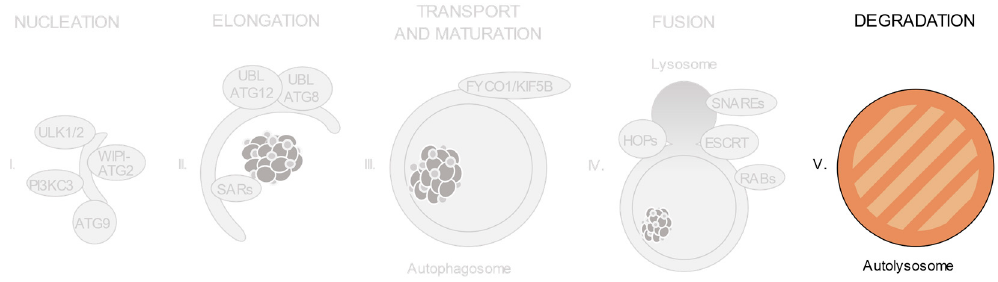
Figure 9. Lysosomal components are direct effectors of autophagosome cargo degradation.